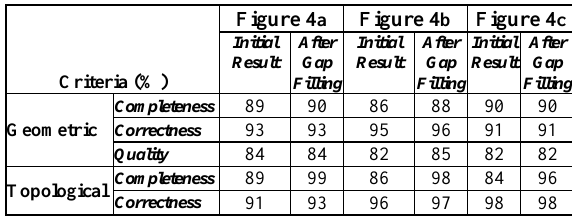
Table 2. Evaluation of extracted network in the second